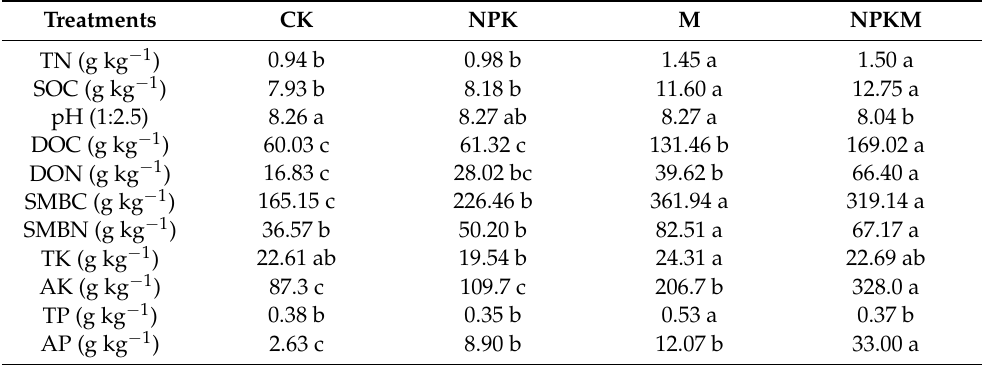
Table 1. Soil basic properties under different treatments after 16 years of fertilization. Treatments CK NPK